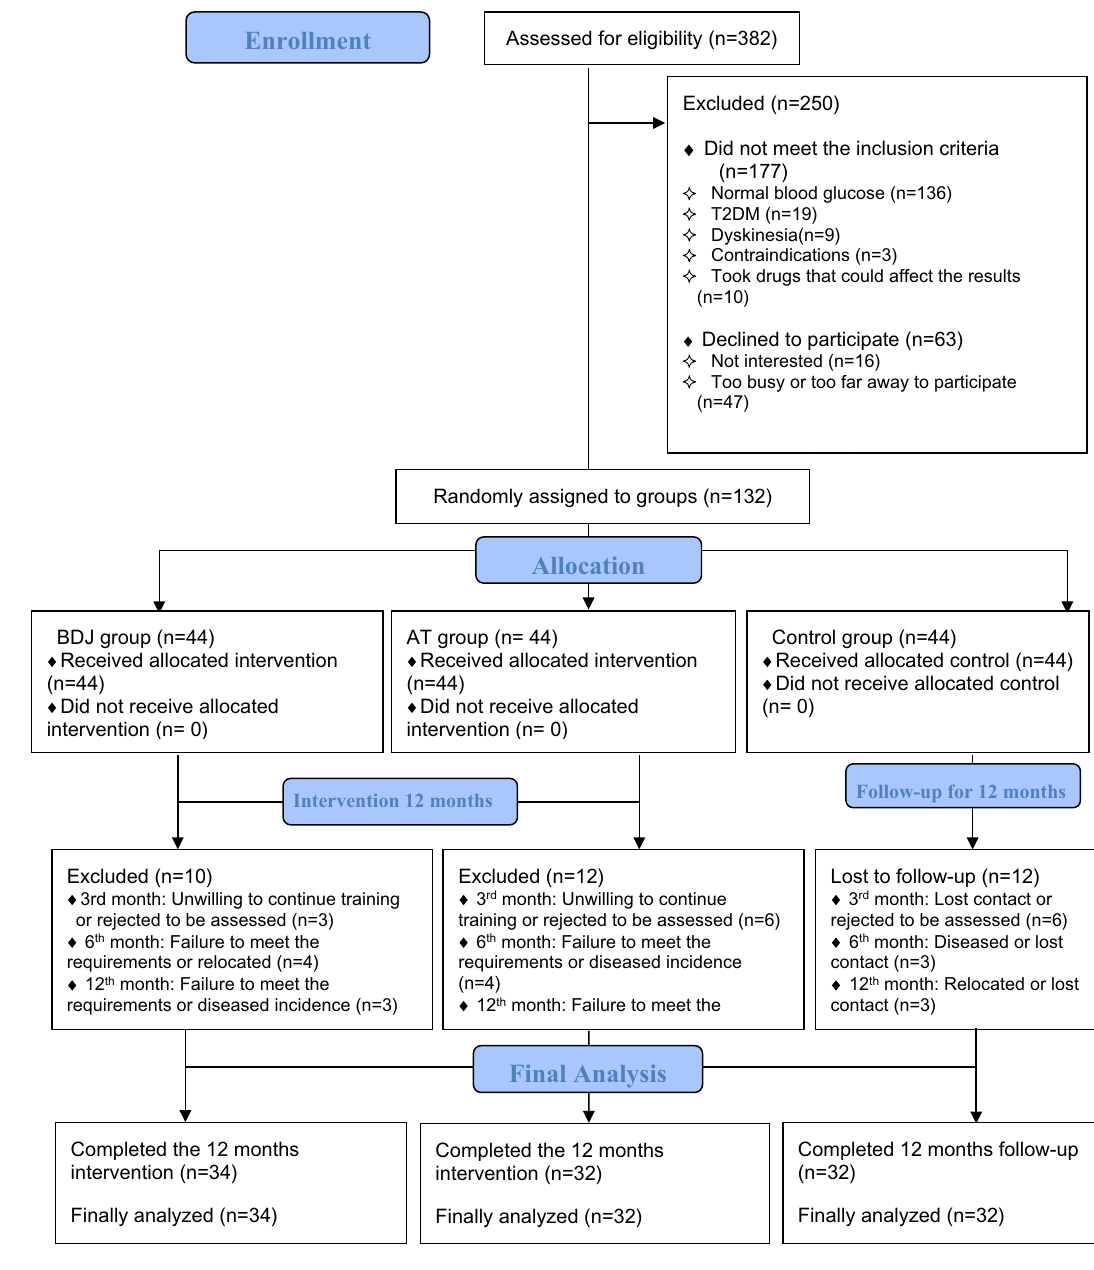
Figure 1. Flowchart of participant enrolment, allocation, and